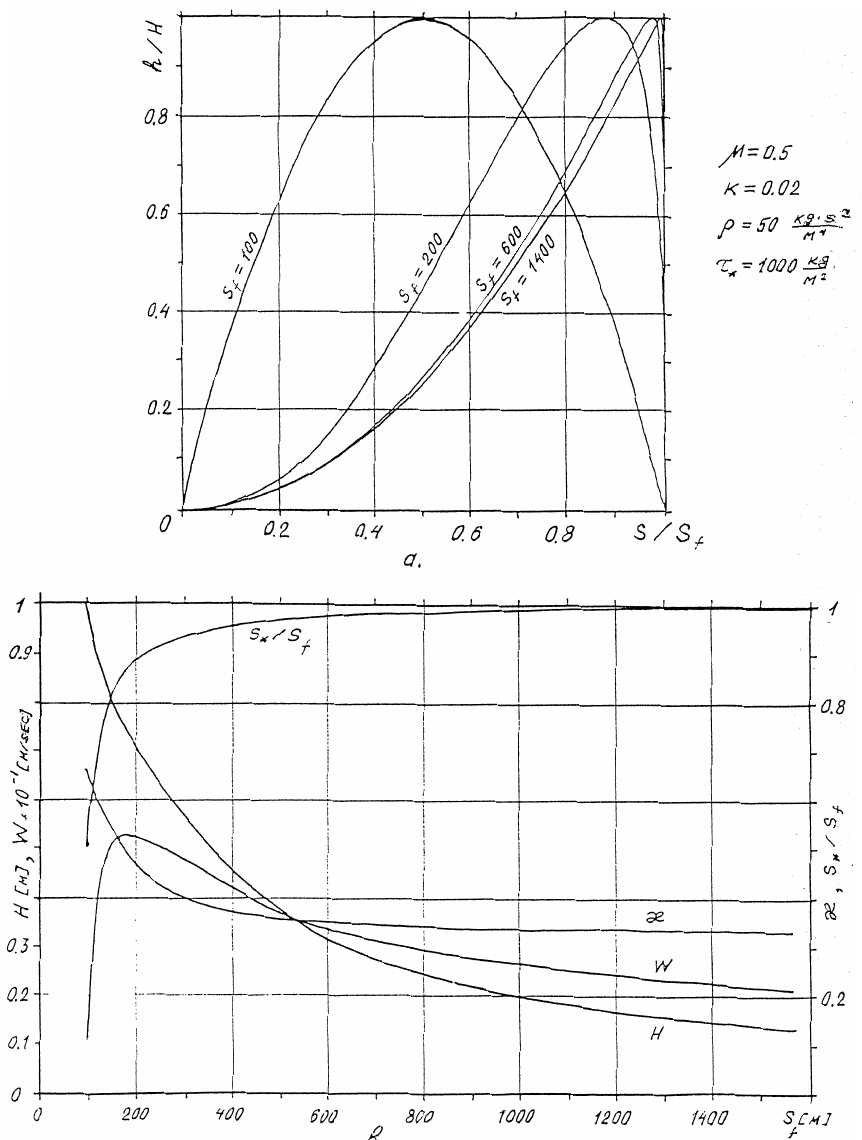
Figure 5. Representative example (variant 1 in Tables 1 and 2) of simulation results from the full model on an inclined plane (slope angle 30 ◦ ). The flow started with a parabolic shape with maximum depth 1m and a uniform initial velocity of 10ms − 1 . The friction coefficients are µ = 0.5 and k = 0.02, the density is ρ = 500kgm − 3 and the strength of the snow cover 10kPa. ( a ) Evolution of the longitudinal profile of the flow depth h , scaled by the instantaneous front positions, S f (in m), and maximum depth H ( S f ) , of the flow. ( b ) Evolution of the relative position of the maximum flow depth, S ∗ / S f , of the shape factor κ , the front velocity w and the maximum flow depth H with front position S f